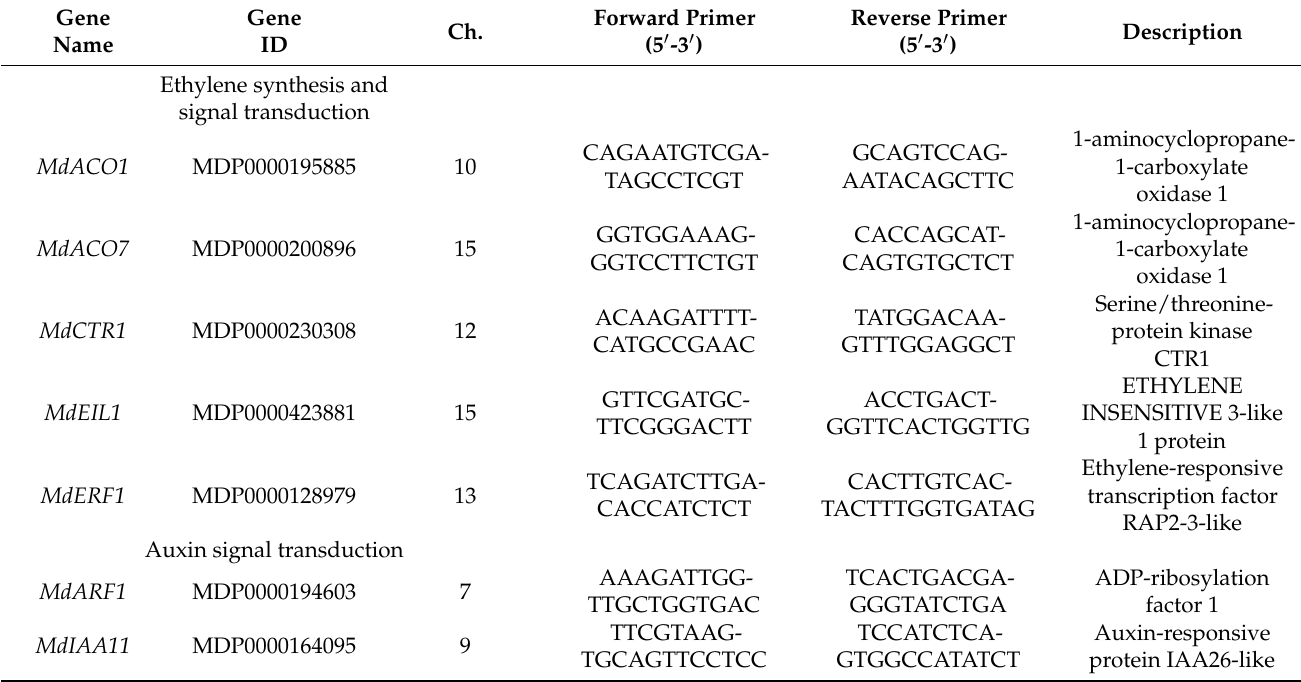
Table 1. Gene information and primer pairs related to fruit maturation and used in